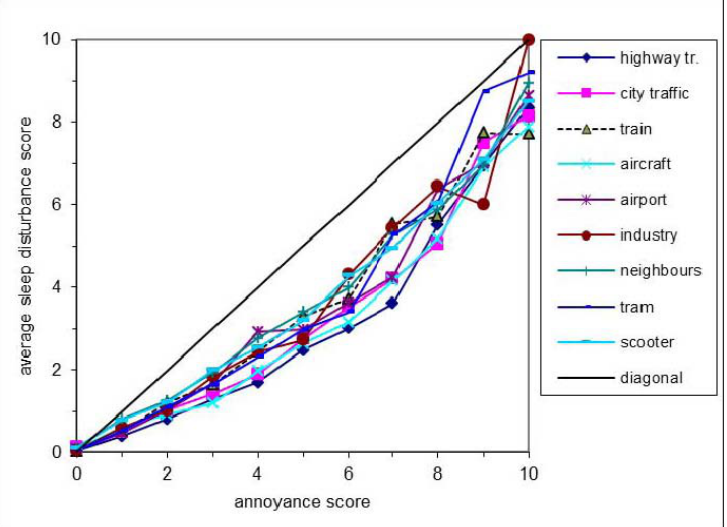
Figure 3. Relation between average sleep disturbance and annoyance scores per noise